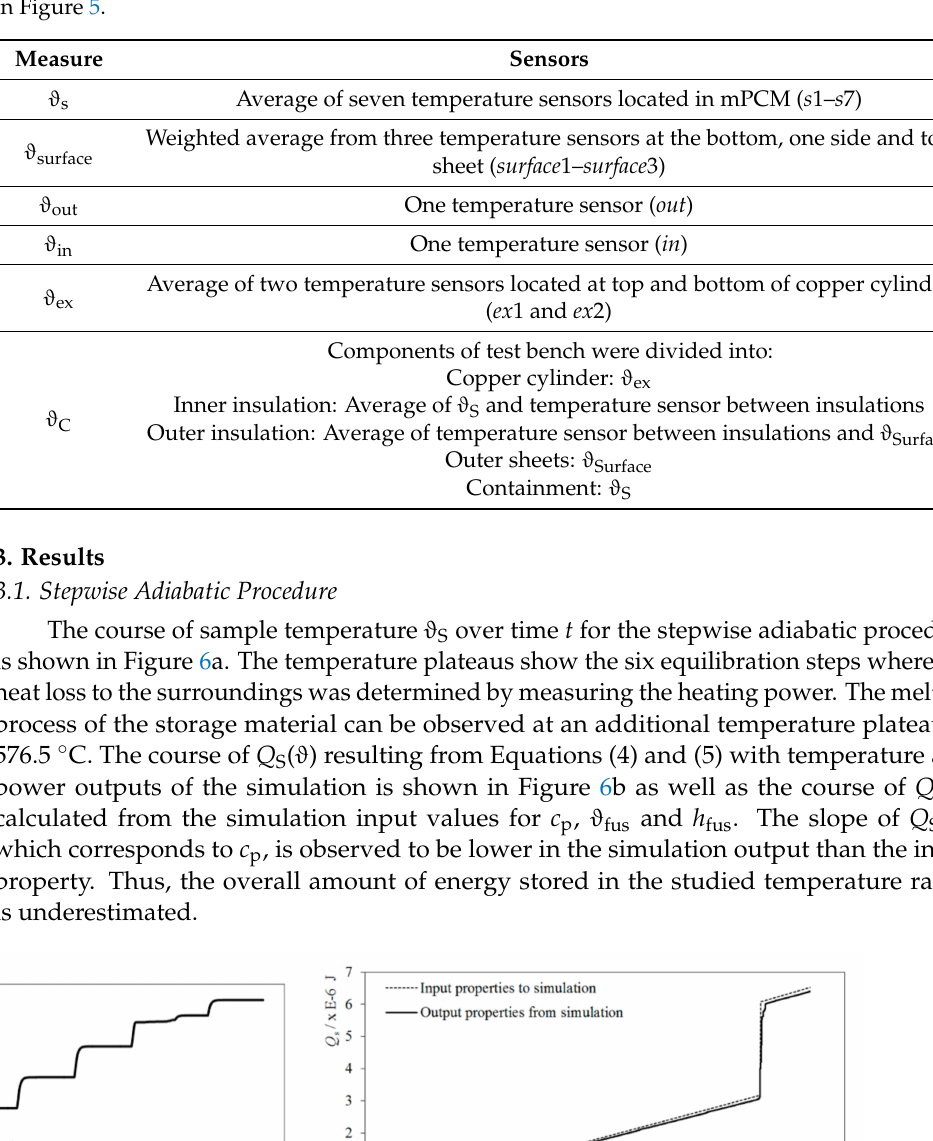
Table 2. Temperature sensors used to measure relevant temperatures for procedure evaluation (for cylindrical components, logarithmic average was used). In italics are positions of sensors as marked in Figure 5.